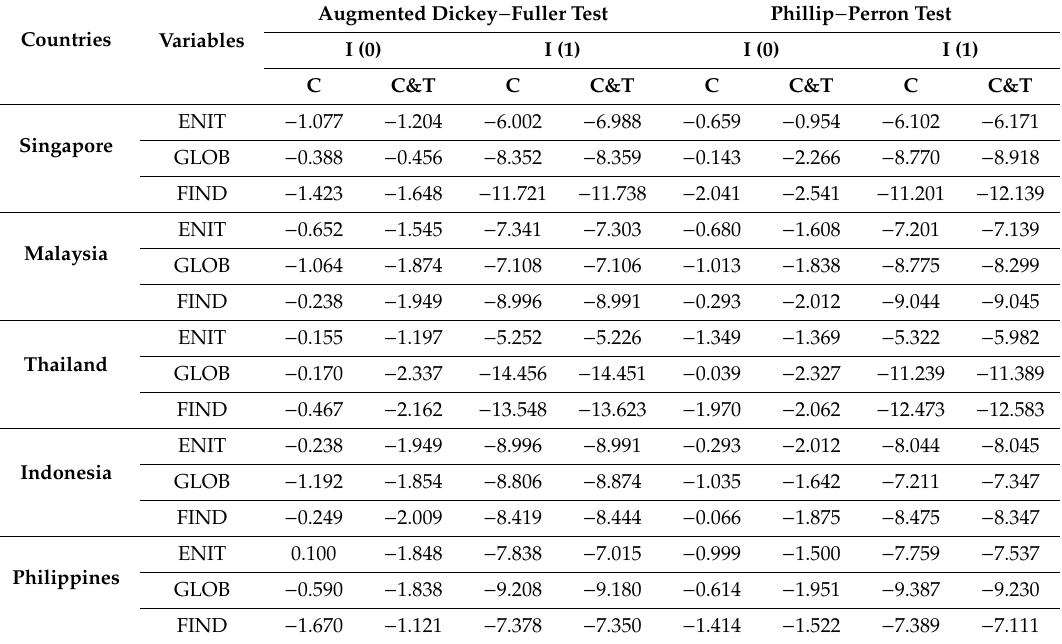
Table 2. Results of the Unit Root